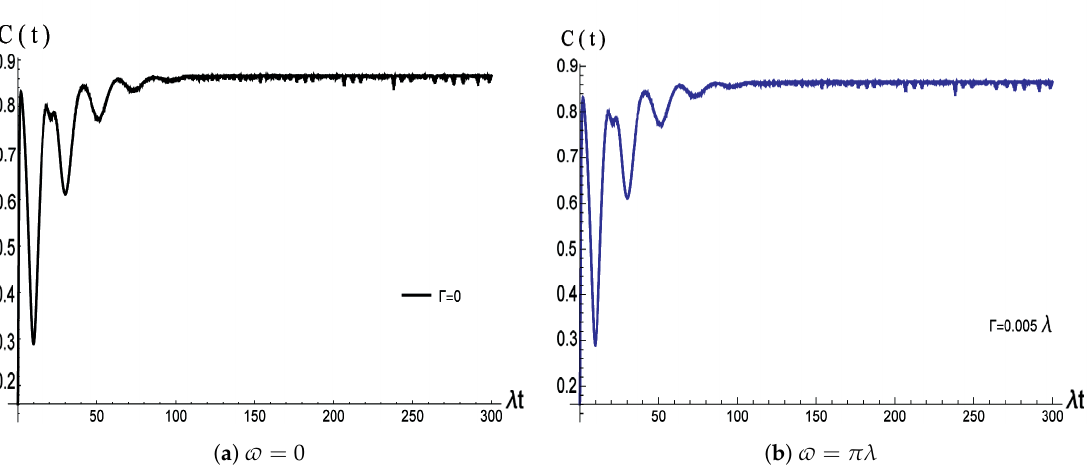
Figure 4. The evolution of concurrence C ( t ) vs. the scaled time, for the one-photon process ( κ = 1), θ = π /4, ω j = Ω j = 0.1 λ , γ j = 0, and ¯ n j = 10.